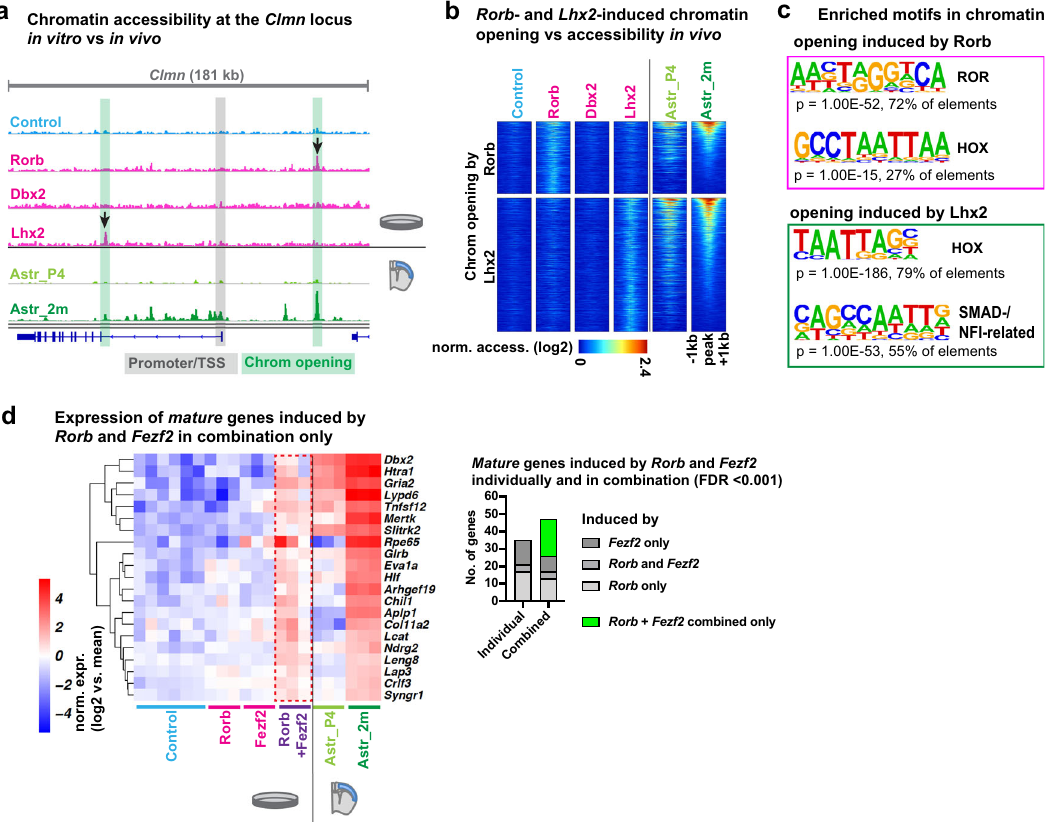
Fig. 6 Transcription factors induce chromatin opening and cooperate to control maturation-regulated genes. a ATAC-Seq genome tracks showing chromatin accessibility peaks around the transcriptional start site (TSS) of the mature gene Clmn in cultured astrocytes expressing transcription factors and in brain astrocytes (at postnatal day 4 (Astr_P4), and 2 months of age (Astr_2m)). Note the highlighted peaks that are present in cultured astrocytes only when Rorb or Lhx2 are expressed. b Heatmaps showing chromatin accessibility in cultured astrocytes around Rorb - and Lhx2 -induced peaks and in brain astrocytes. c Transcription factor motifs enriched in Rorb - and Lhx2 -induced peaks (de novo motif enrichment analysis). d Expression of mature astrocyte- speci fi c genes induced by the combined expression of Rorb and Fezf2 . Astrocytes co-infected with Rorb- and Fezf2-inducing viruses were analysed along with samples from Fig. 5. Statistical analysis and data presentation: a ATAC tracks represent merged reads of 3 replicates (4 for Astr_2m, 6 for Control). b Heatmaps show normalized ATAC read count of merged samples in 20 bp windows ±1 kb of peak centres. Differential peaks: DESeq2 analysis, each n = 3 ( n = 4 for Astr_2m, n = 6 for Control); two-sided Wald test with Benjamini – Hochberg correction; signi fi cance threshold: adjusted p -value ≤ 0.05, absolute log2(fold change) ≥ 1. Shown are log2-transformed normalized expression values. d Differential genes: DESeq2 analysis, each n = 3 ( n = 6 for Control); two-sided Wald test with Benjamini – Hochberg correction; signi fi cance threshold: adjusted p -value (FDR) ≤ 0.001, absolute log2(fold change) ≥ 1. Shown are log2-transformed mean centred, normalized expression values. See also Supplementary Fig. 8, Supplementary Data